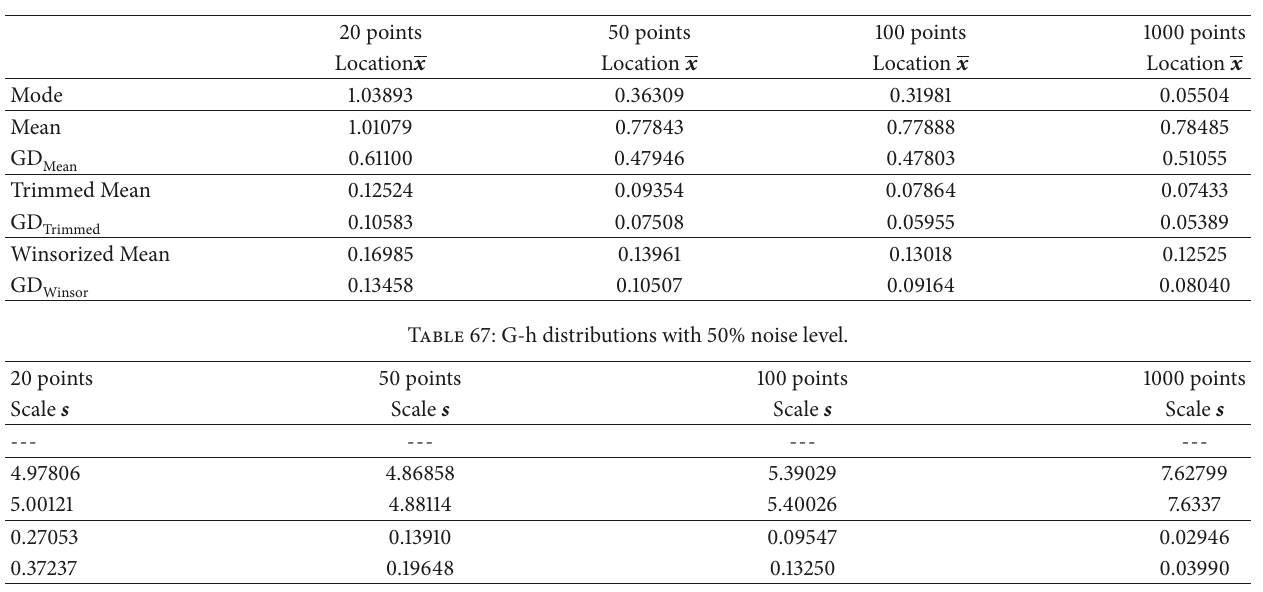
Table 66: G-h distributions with 50% noise level.